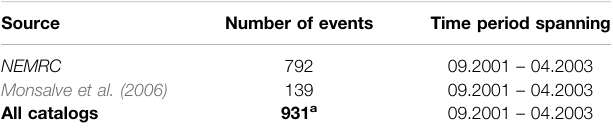
TABLE 1 | Details of candidate intermediate-depth events (recorded with ≥ 40 km hypocentral depths) from existing catalogs. Dates are in month/year format